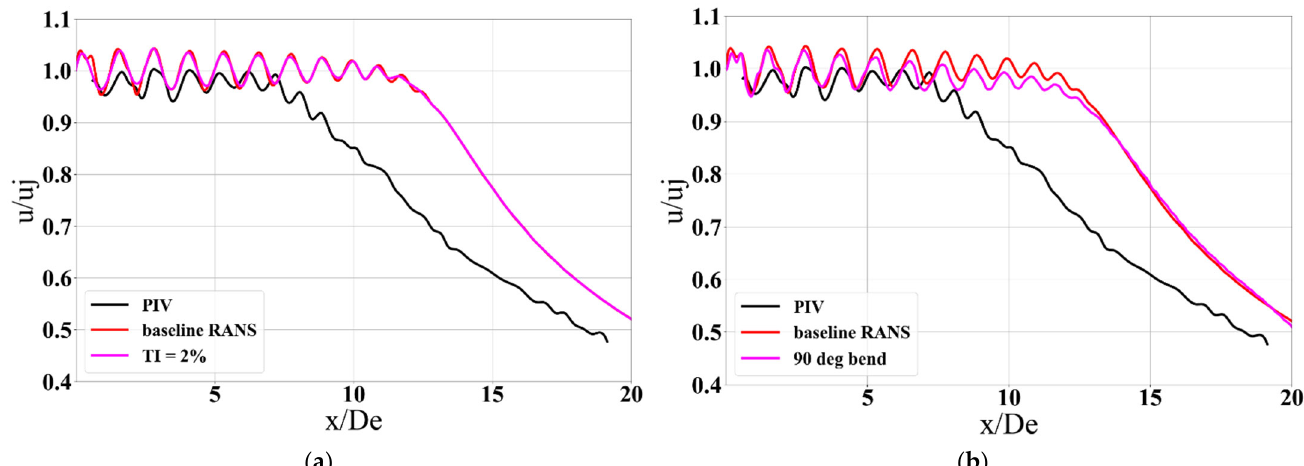
Figure 6. Effect of inflow conditions compared with PIV data from [60]. ( a ) Effect of turbulence intensity (TI). ( b ) Effect of upstream air supply duct.